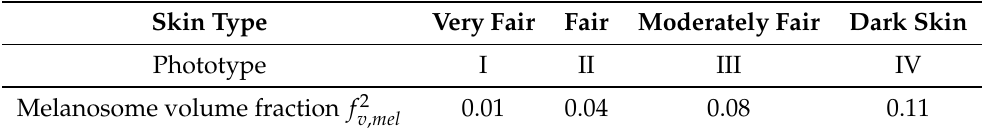
Table 3. Values of the volume fraction of melanosome in the living epidermis used for simulating